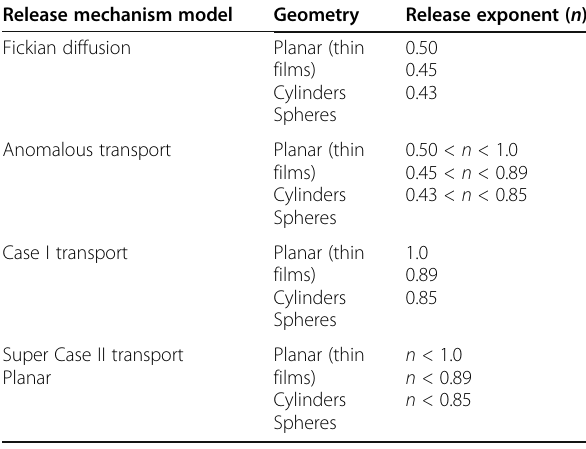
Table 2 Summary of different release characteristics depending on release exponent n of Korsmeyer-Peppas